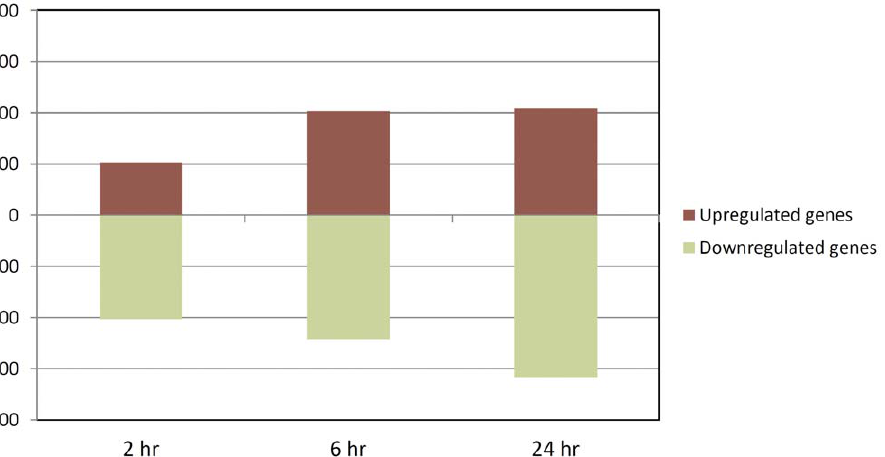
Figure 3. The number of significantly differentially expressed genes at each time point post- M.bovis challenge. The number of upregulated and downregulated genes in the M. bovis -challenged MDM relative to the control MDM at each time point are shown (adjusted P -value 0.05).